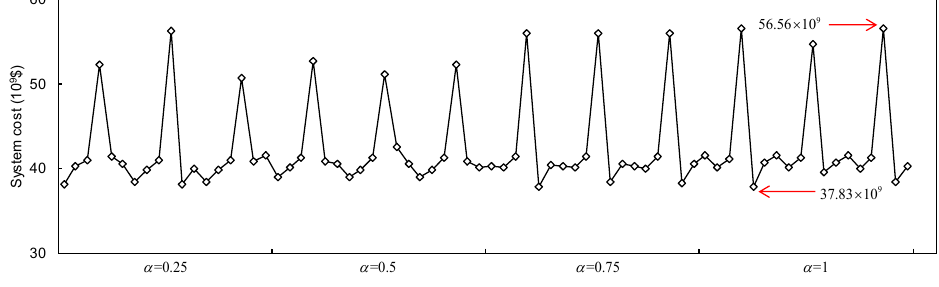
Figure 6. System cost under different levels.